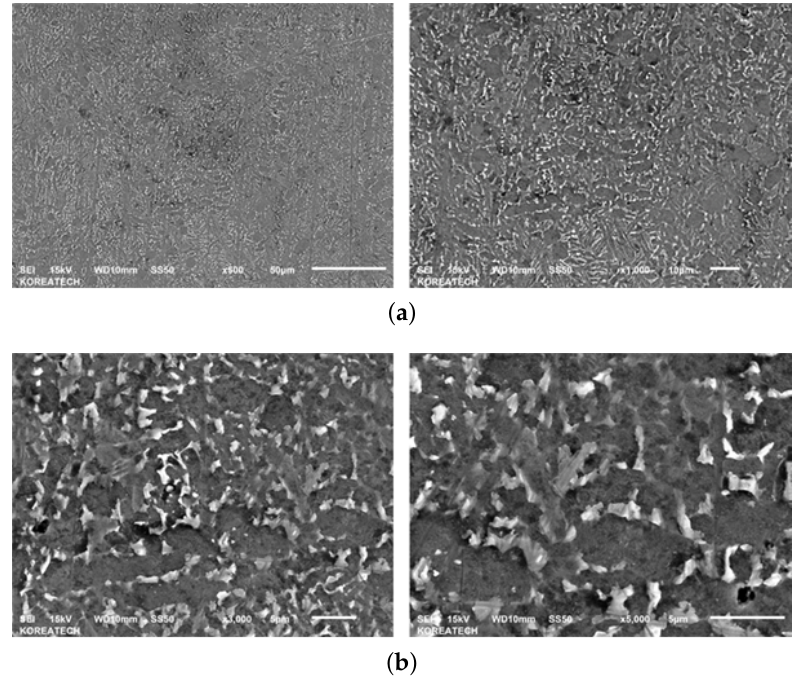
Figure 15. Microstructure of Material sample C—Scanning Electron microscopy (SEM). ( a ) Material sample C (500 and 1000 × ); ( b ) Material sample C (3000 and 5000 ×